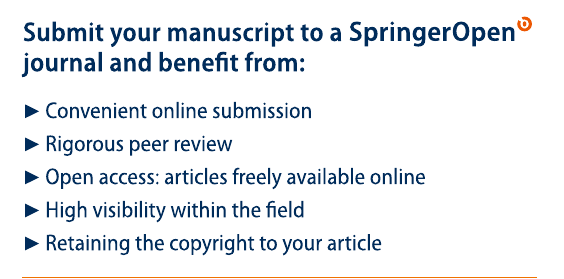
Wu Y (2000) Measuring the performance of foreign direct investment: a case study of China. Econ Lett 66(2):143 – 150 https://